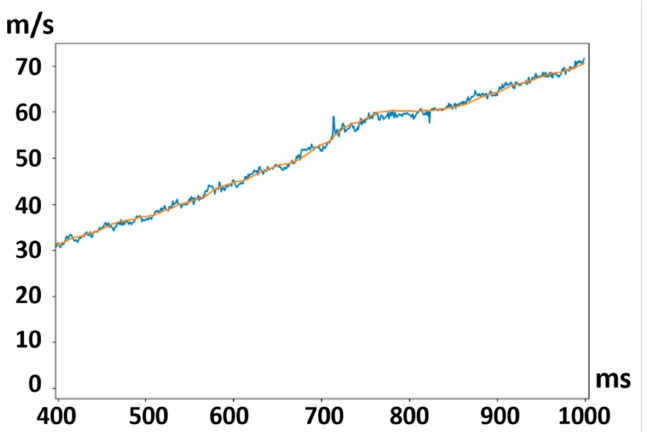
Figure 10. Output response with EKF of level